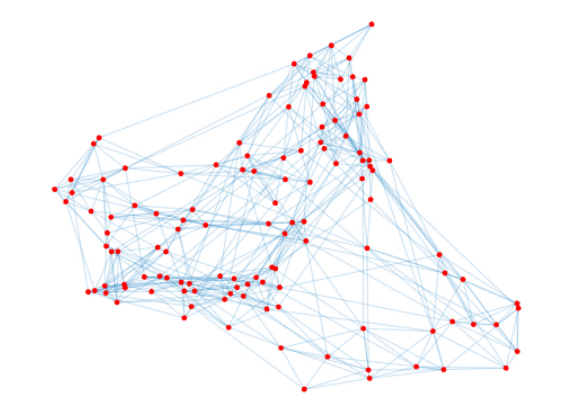
Figure 10. Small world